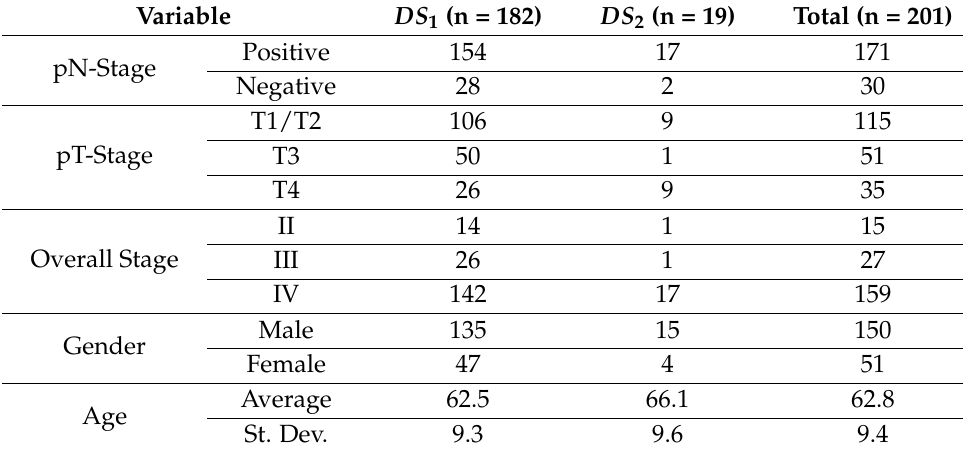
Table 1. Distribution for the chosen outcomes, gender and